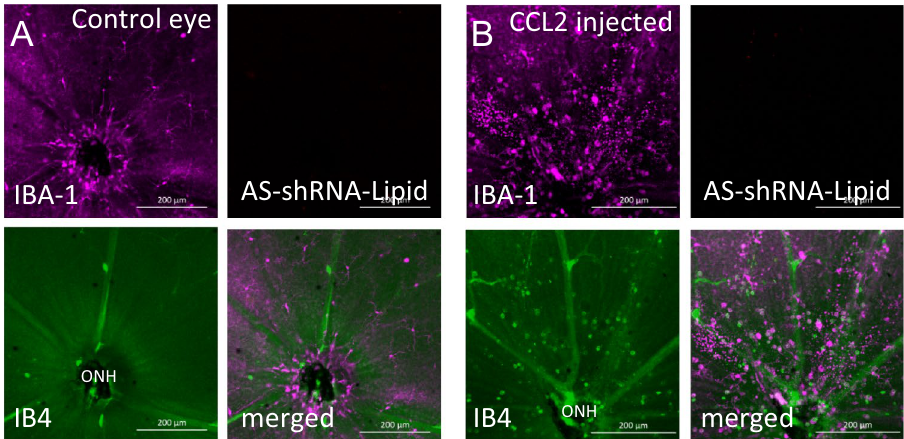
Figure 7. Endoglin mRNA targeted AS-shRNA–lipid derived fluorescence was monitored in mice with intraocular injection of recombinant CCL2 protein in one eye and used the other eye as un-injected control to confirm the specificity of the AS-shRNA–lipid probes. IBA1 was used to visualize the microglia/macrophages in the retina and IB4 was used to visualize the vascular structures. Under anesthesia, CCL2 (2 μL) was injected intraocularly followed by intraperitoneal injection of AS-shRNA–lipid (0.5 mg/kg). After 18 h mice were sacrificed for analysis (n = 5). ( A ) Ramified IBA1 positive microglia/macrophages were observed in the un-injected control eye. ( B ) A large number of IBA1 positive amoeboid shaped microglia/macrophages were observed in the CCL2 recombinant protein injected eyes, generally around the optic nerve head (ONH). However, AS-shRNA–lipid derived fluorescence were not observed in IBA1 positive cells in un-injected control eyes as well as in CCL2 injected eyes, suggesting that the AS-shRNA–lipids are specific for microglia/ macrophages that are associated with